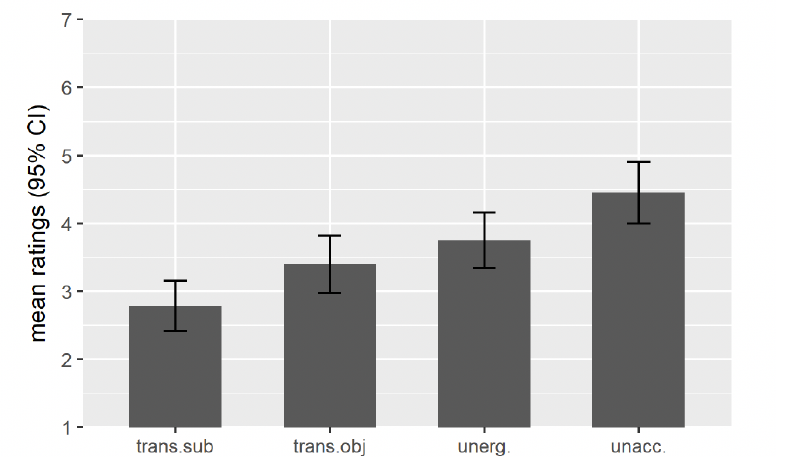
Figure 9. Acceptability of extraction of von wem ‘by whom’ from NP in German (Konietzko